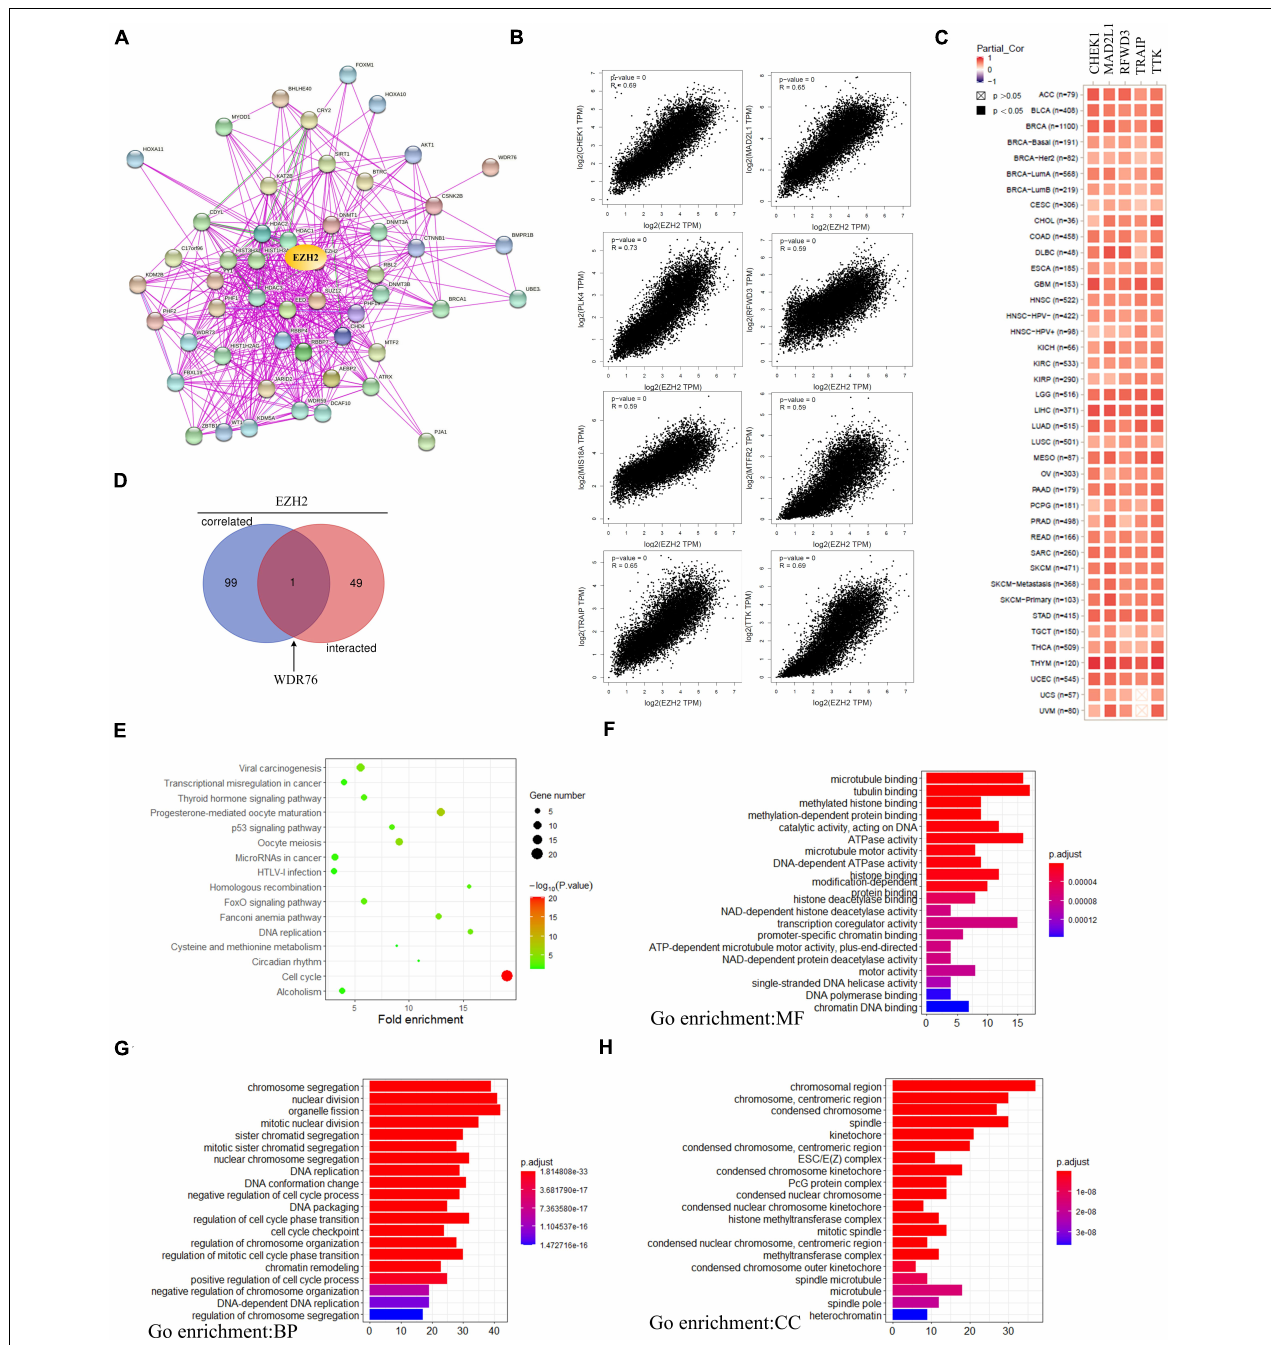
FIGURE 10 | EZH2-related gene enrichment analysis. (A) The EZH2-binding proteins using the STRING tool. (B) The top 100 EZH2-correlated genes in TCGA projects and analyzed the correlation between EZH2 and selected targeting genes. (C) The corresponding heatmap data in the detailed cancer types are displayed. (D) An intersection analysis of the EZH2-binding and correlated genes was performed. (E) KEGG pathway analysis was performed. (F–H) The GO pathway analysis was performed.